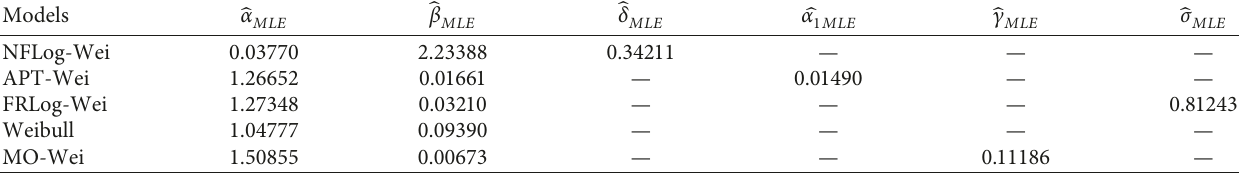
, 􏽢 β , 􏽢 δ , 􏽢 α , 􏽢 c MLE MLE MLE , and MLE 1 MLE